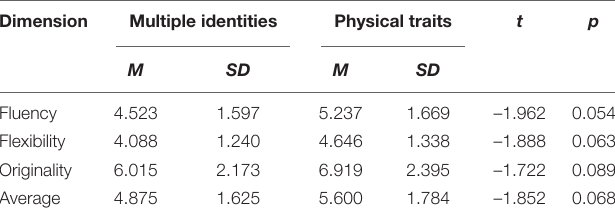
TABLE 1 | Divergent thinking (DT) scores for multiple identities and physical traits conditions ( N = 76).